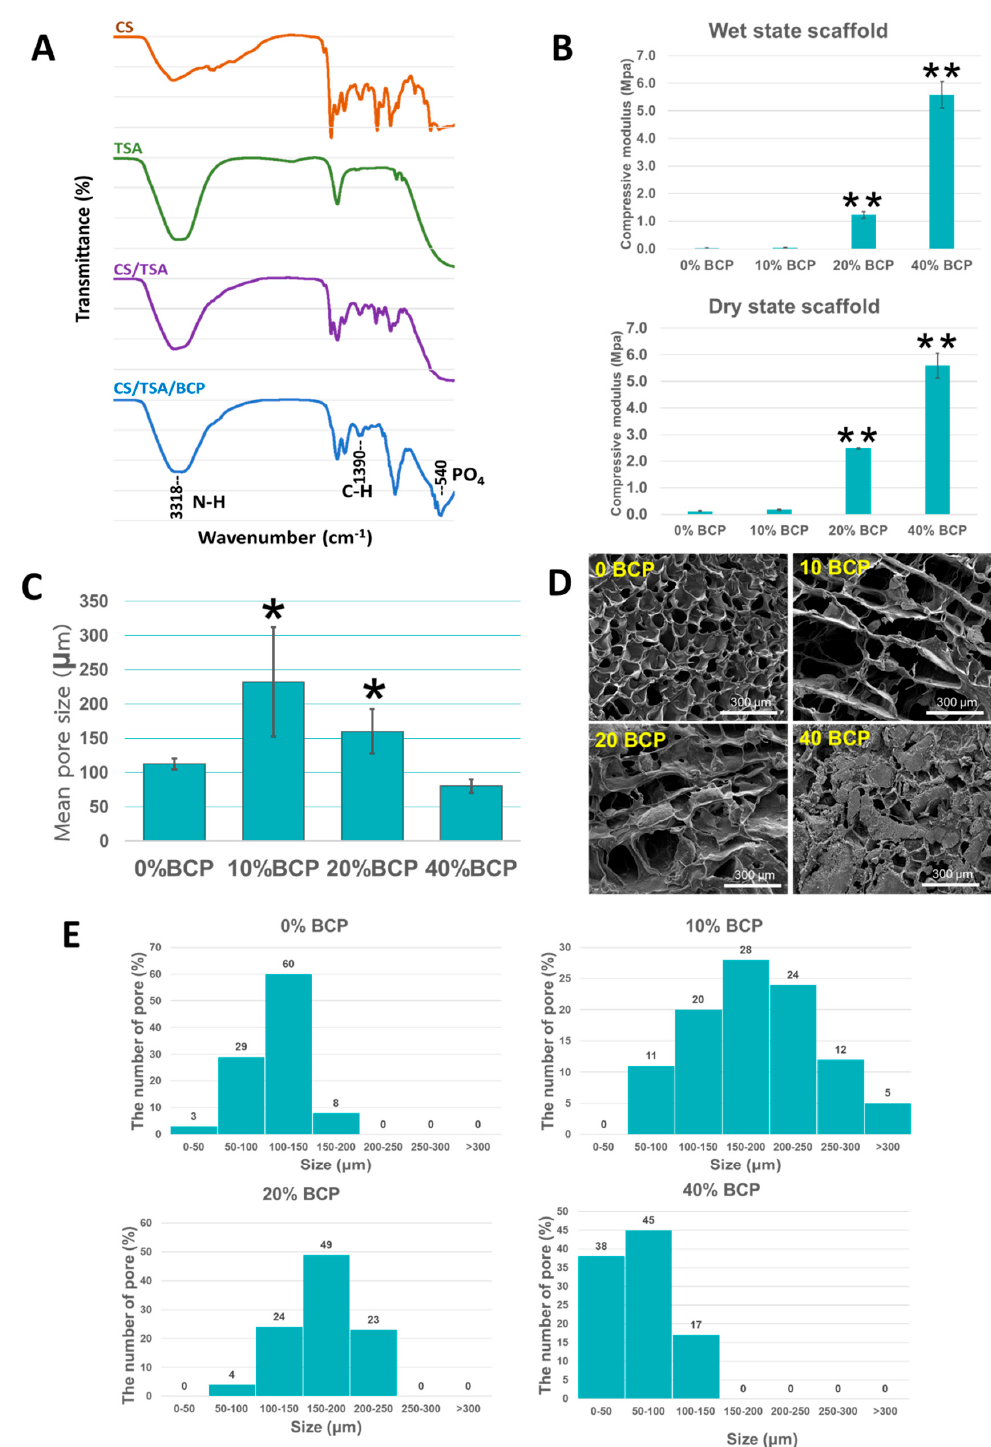
Figure 2. Physical characterization of CS/BCP/TSA scaffolds in various BCP proportions. ( A ) FT-IR spectra of CS/BCP/TSA scaffolds showed the absorption peak at 540, 600, 1390, and 3318 cm − 1 , representing each scaffold compartment. ( B ) With the increase in BCP proportion, the compressive strength of the scaffolds in the wet state was increased. ( C ) The mean pore size of CS/BCP/TSA scaffolds in various BCP proportions. ( D ) The SEM surface morphology of CS/BCP/TSA scaffolds in various BCP proportions. ( E ) The pore size distribution of CS/BCP/TSA scaffold in various BCP proportions. Values are defined as mean ± SD. * p < 0 . 05; ** p < 0 . 01 .